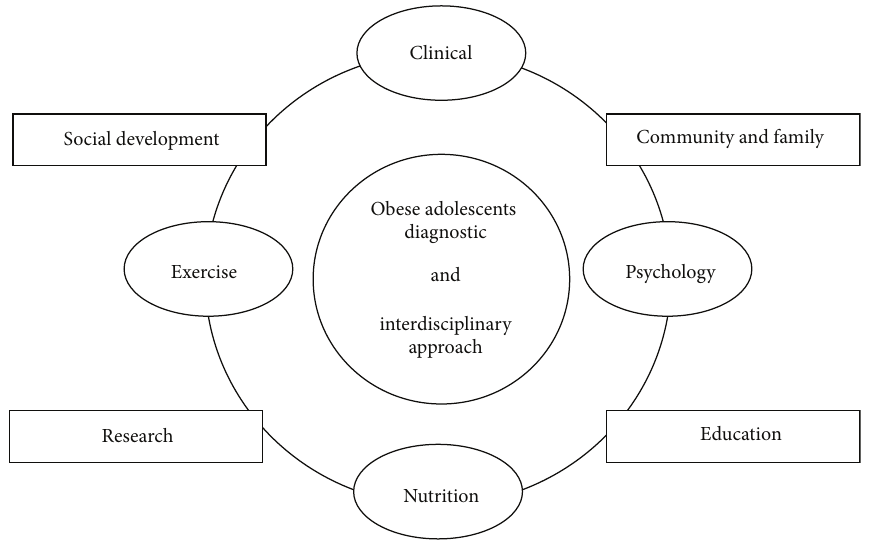
Figure 1: Design conception of interdisciplinary therapy on obesity management in